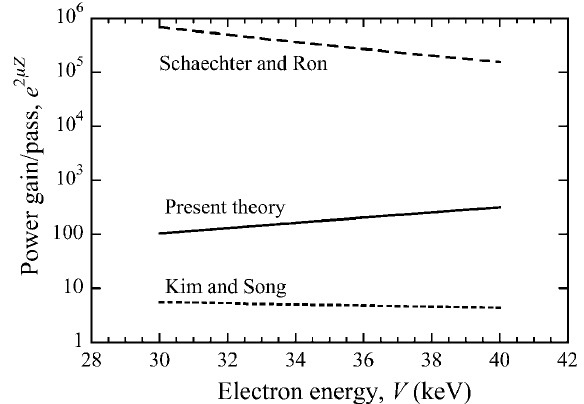
FIG. 5. Total power gain per pass for the experimental pa- rameters of Urata and Walsh: present theory (solid line), Kim and Song (dotted line), Schaechter and Ron (dashed